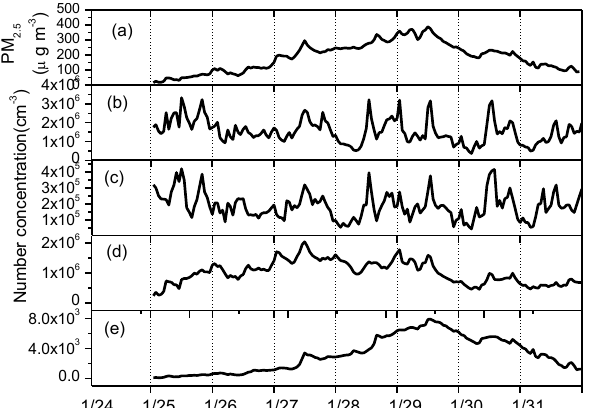
Figure 6. Time series of (a) particle mass concentration calcu- lated from number-size distribution and number concentrations of (b) nucleation mode (14.1–25nm), (c) Aitken mode (25–100nm), (d) accumulation mode (100–1000nm) and (e) coarse mode (1000– 2458nm) from 25 to 31 January.